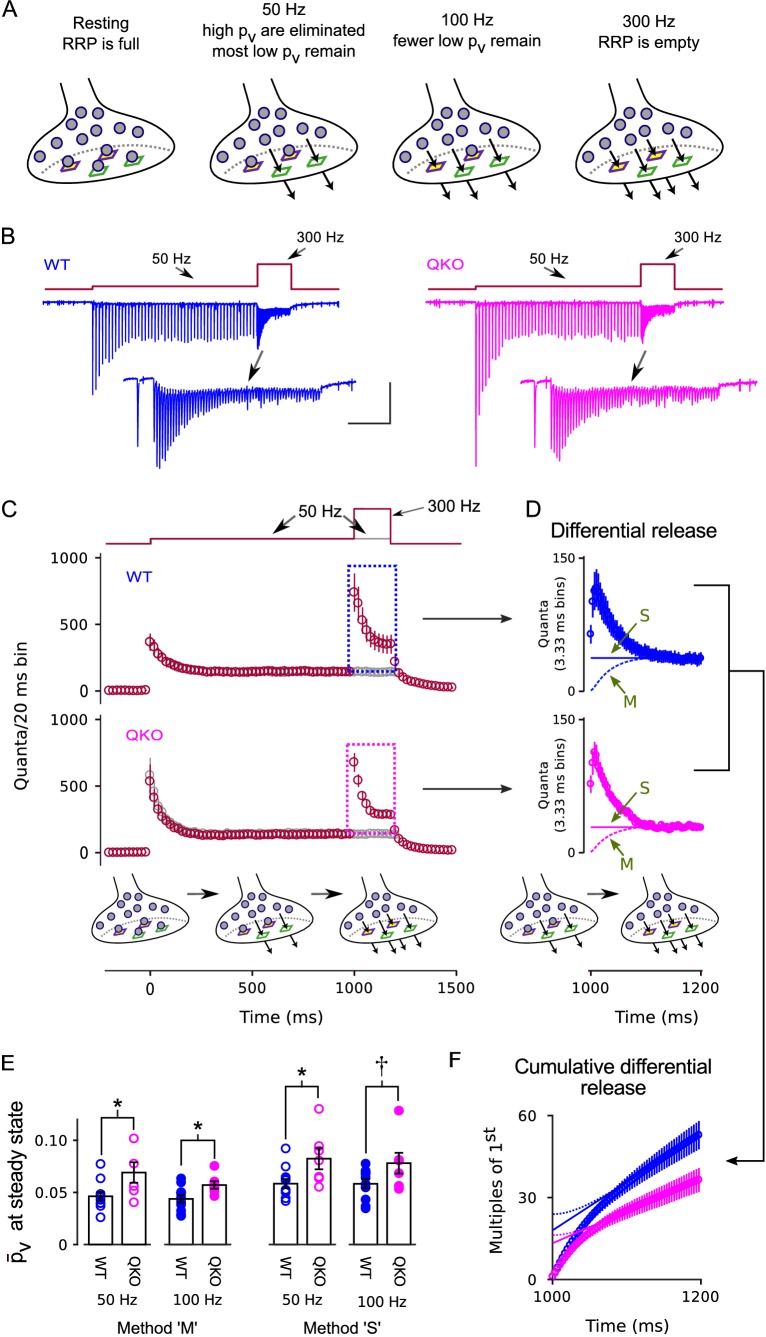
Enhanced release of vesicles with low pv remaining in RRP after 50 Hz or 100 Hz stimulation at QKO synapses.(A) Diagram illustrating the steady state contents of the RRP for a range of stimulating frequencies. Release sites are depicted as stable, and are characterized by either a high (green squares) or a low (purple squares with yellow interior) probability of catalyzing the exocytosis of docked vesicles (i.e. high or low pv release sites). Alternative models where the readily releasable vesicles transition back and forth between high and low pv states would be the same except the release sites would not have a defined pv when empty, and the locations of the high and low pv vesicles would change over time. In either case, 50 Hz and 100 Hz stimulation is rapid enough to eliminate the vesicles with high pv from the RRP, but leaves a flow through pool of low pv vesicles that can then be released by subsequent 300 Hz stimulation. (B) Example recordings for trials where the stimulation frequency was increased from 50 Hz to 300 Hz; blue is WT, magenta is QKO. The insets are the last response during 50 Hz stimulation and responses during subsequent 300 Hz stimulation. The scale bars pertain to both sets of traces: the vertical bar is 1 nA and the horizontal is 250 ms for the full traces; and 500 pA and 50 ms for the insets. (C) Mean responses for the full data set quantified as the number of quanta released during sequential 20 ms segments, allowing direct comparison of the time-averaged rate of release when stimulation was 50 vs when 300 Hz; single segments contain the quantal content of responses to single action potentials for times when the stimulating frequency was 50 Hz, and of responses to 6 consecutive action potentials when the frequency was 300 Hz. Red symbols are for trials where stimulation was increased from 50 to 300 Hz, and gray are for trials where stimulation was maintained at 50 Hz throughout, as diagrammed at top. Boxes demarcate responses used to calculate the differential release in (D). (D) The additional release - termed differential release here - elicited by increasing the stimulation frequency to 300 Hz was calculated by subtracting the time-averaged values during continued 50 Hz stimulation from the corresponding values during 300 Hz stimulation. The theoretical curves are estimates of the fraction of the differential release produced by exocytosis of neurotransmitter that was recruited to the RRP during ongoing stimulation. ‘M’ and ‘S’ signify the same as in Figure 3D; ‘M’ describes the model in the illustrations at bottom and in (A). (E) p¯v values for individual calyces during steady state 50 and 100 Hz stimulation using the same methods ‘M’ and ‘S’ used to generate the theoretical curves in (D) († is p < 0.1, * is p < 0.05; n ≥ 7; rank sum). (F) Cumulative version of the plot in (D), except after normalizing by the quantal content of the first differential response. Solid and dashed lines represent theories ‘M’ and ‘S’ as in (D) except offset to match the rightmost data points. Without the normalization, the lines would intersect the y-axis at the value that corresponds to the contents of the RRP at the start of 300 Hz stimulation (Schneggenburger et al., 1999). However, the normalization converts the estimate into multiples of the quantal content of the first response, making the intersection equal to 1/p¯v.